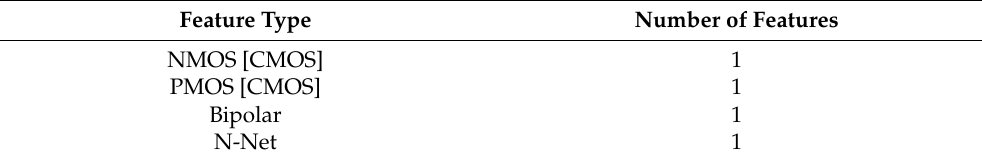
Table 12. Number of features per class while before applying the hyperphysical augmentation.